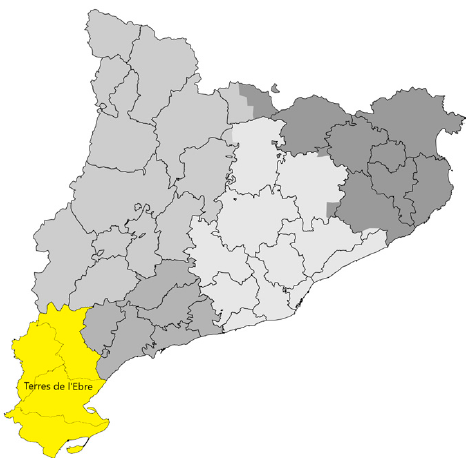
Figure 1. Map of Catalonia, Spain. The Terres de l’Ebre health region.